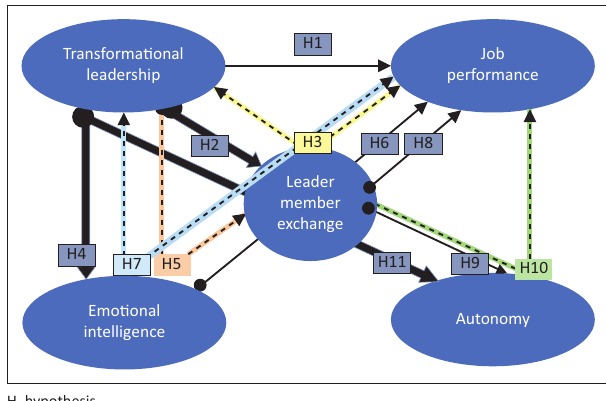
H, hypothesis. FIGURE 1: Conceptual model.